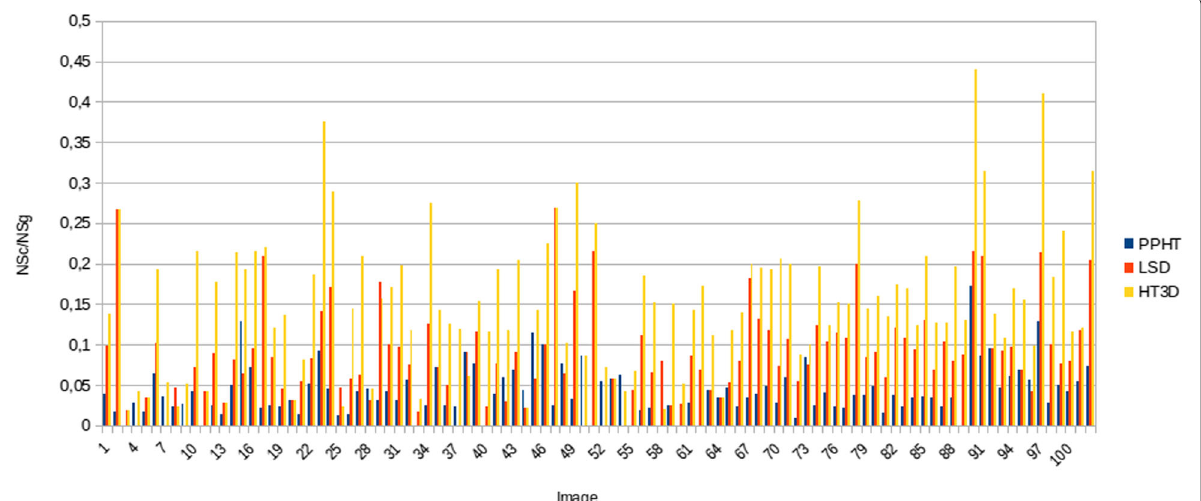
Fig. 26 Ratio between NS c (number of detected segments matching the ground truth data) and NS g (total number of segments of the ground truth data) for the whole dataset considering d S = 2 (distance between ground truth and detected line segments). Differences in the hit rates between the proposed method and the other two approaches for segment detection become more obvious when reducing d S . This denotes the greater accuracy of the proposal in relation to the compared detection